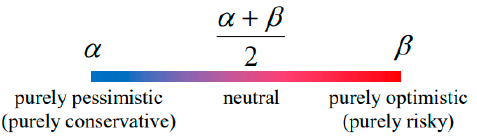
Figure 1. Assessment strategies.